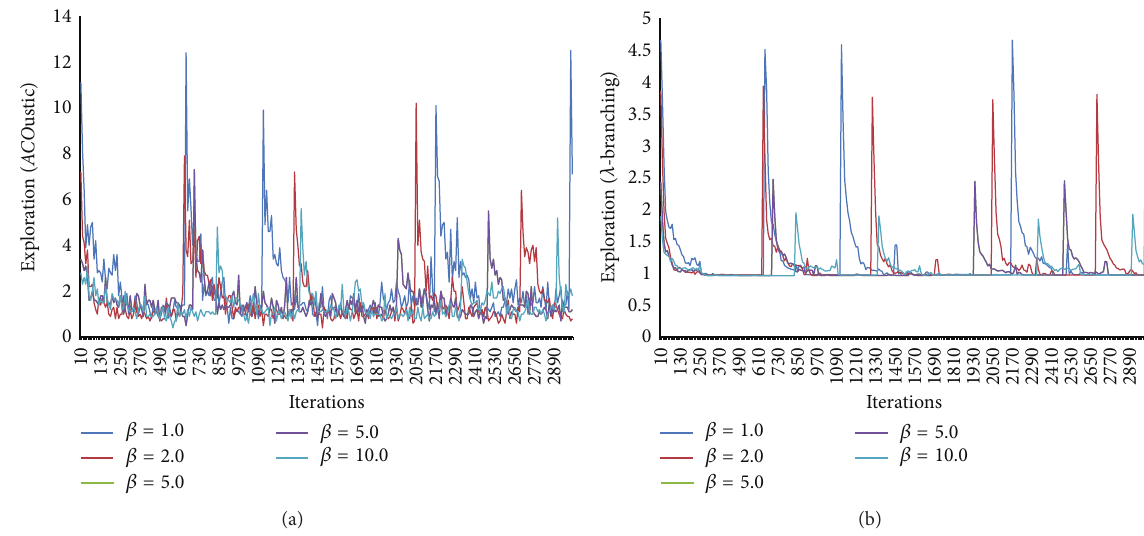
Figure 11: The effect of preheuristic (beta) measured by ACO ustic (a) and measured by 𝜆 -branching (b).